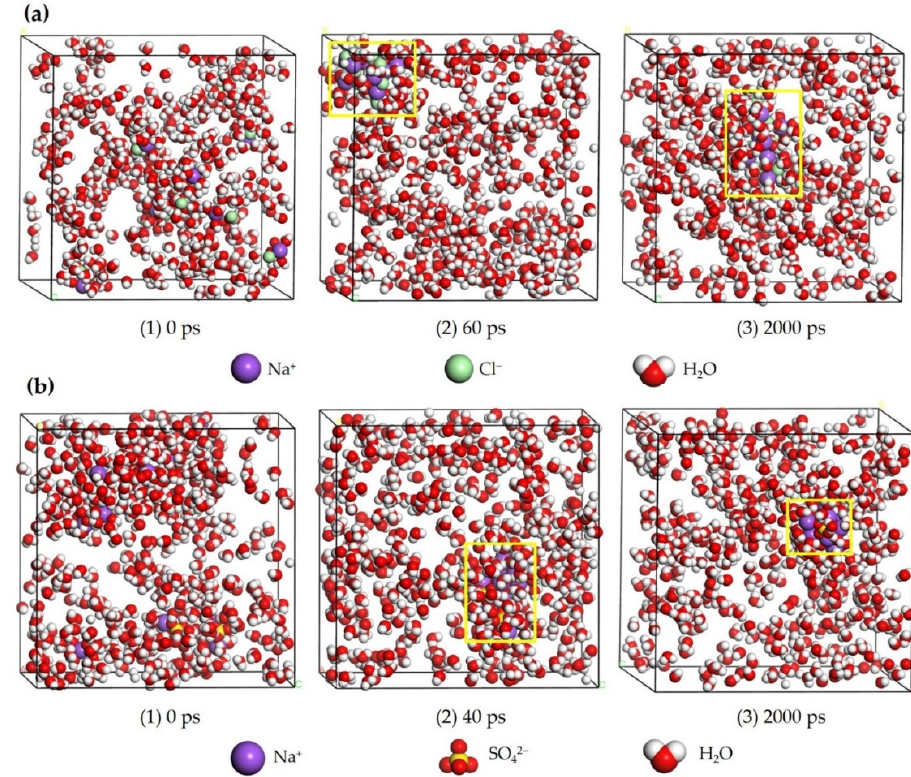
Figure 3. Changes in aggregation and sedimentation process in supercritical water: ( a ) NaCl; ( b ) Na 2 SO 4 .